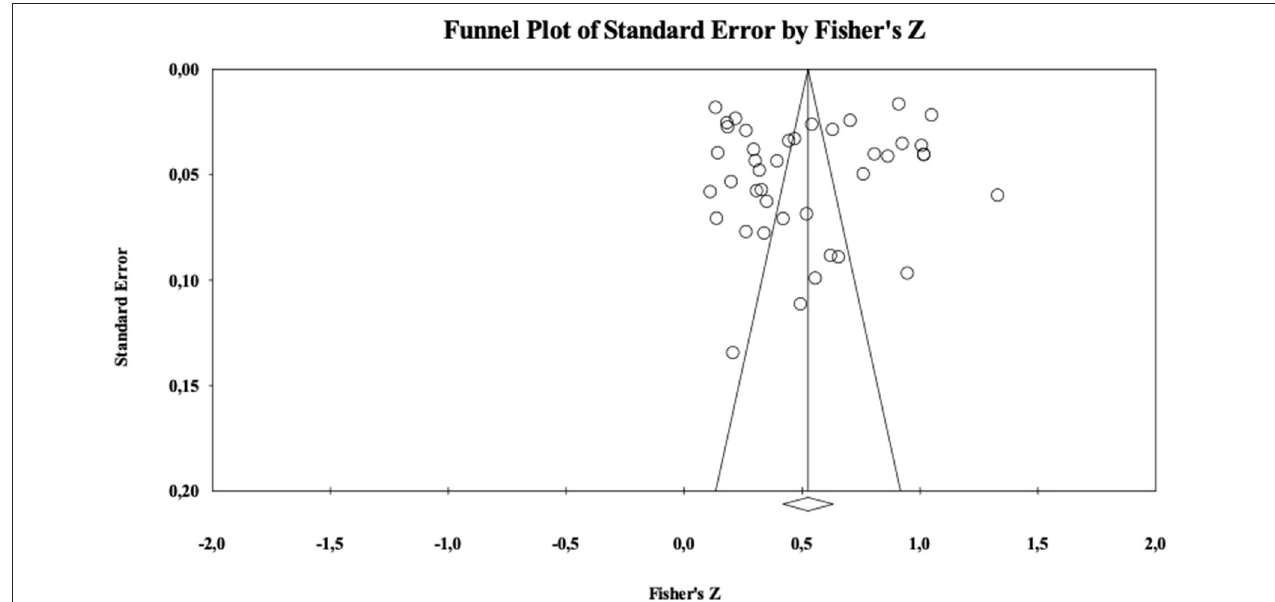
FIGURE 2 | Funnel plot for attitudes.